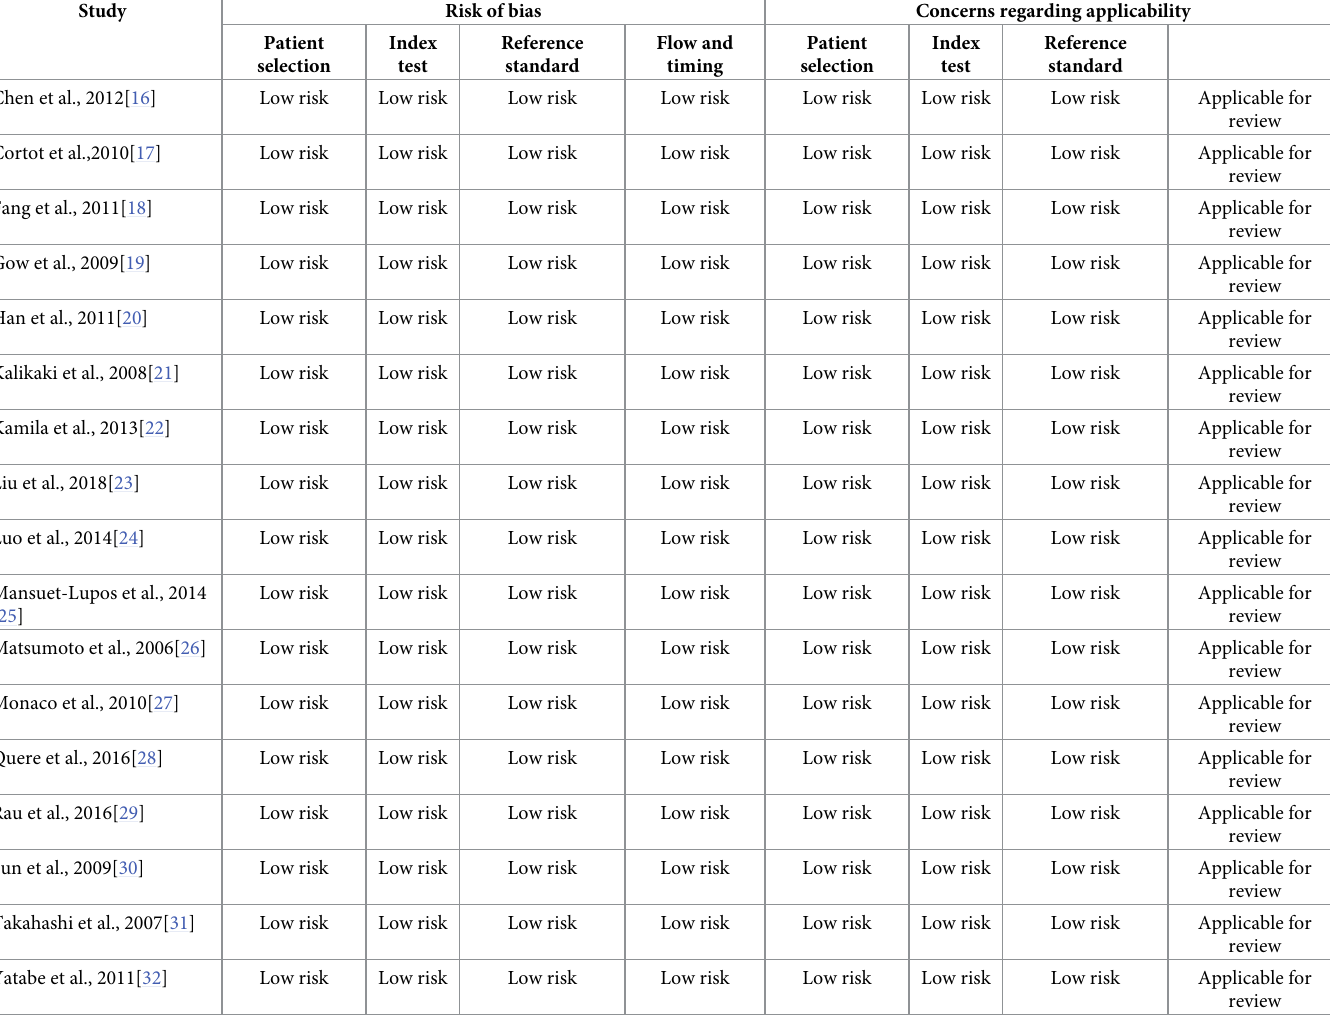
Table 1. Critical appraisal according to